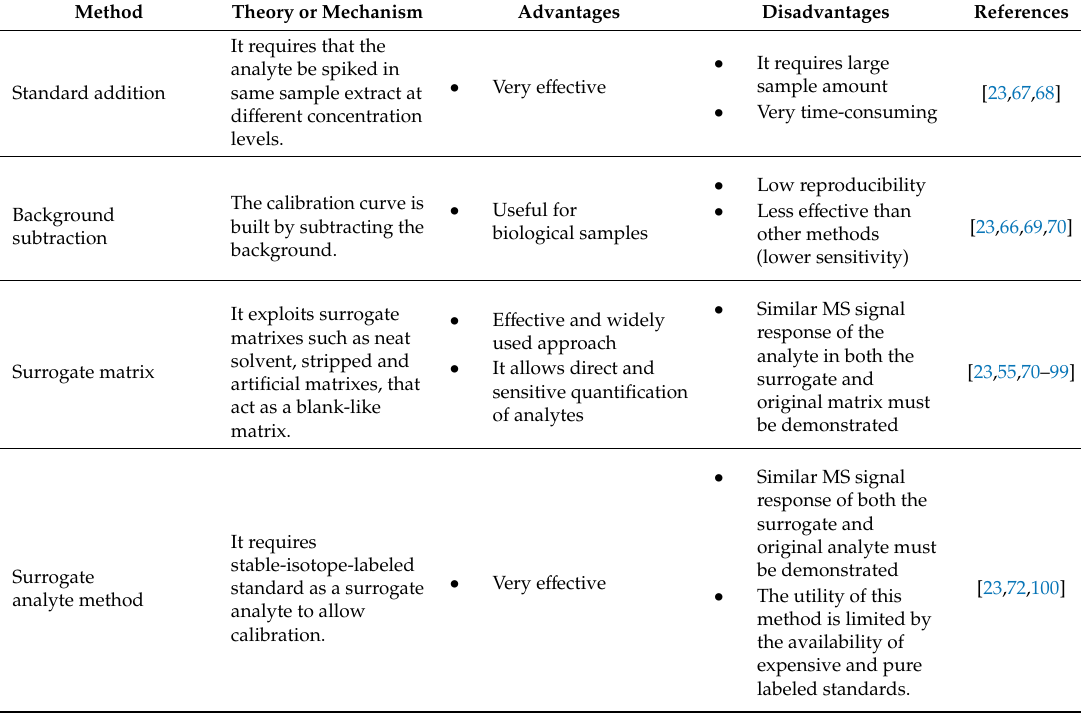
Table 3. Calibration approaches applied when the blank matrix is not